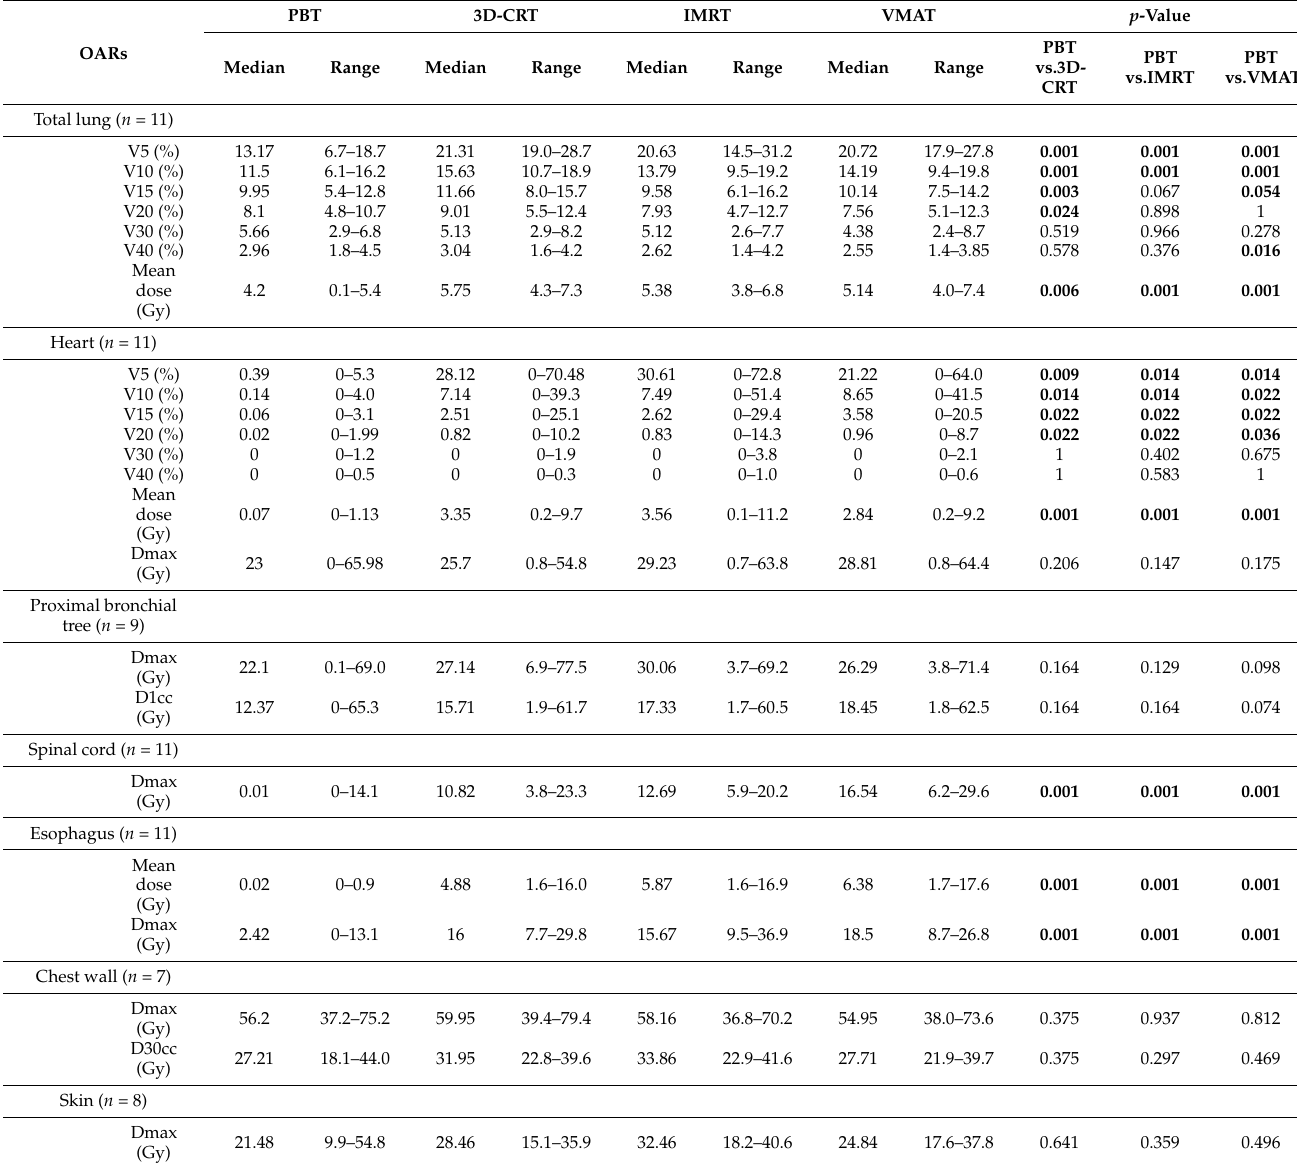
Table 2. Summary and comparison of the dosimetric parameters of centrally located tumors (50 CGE/4 fx = 4, 70 CGE/10 fx = 5, and 60 CGE/10 fx =